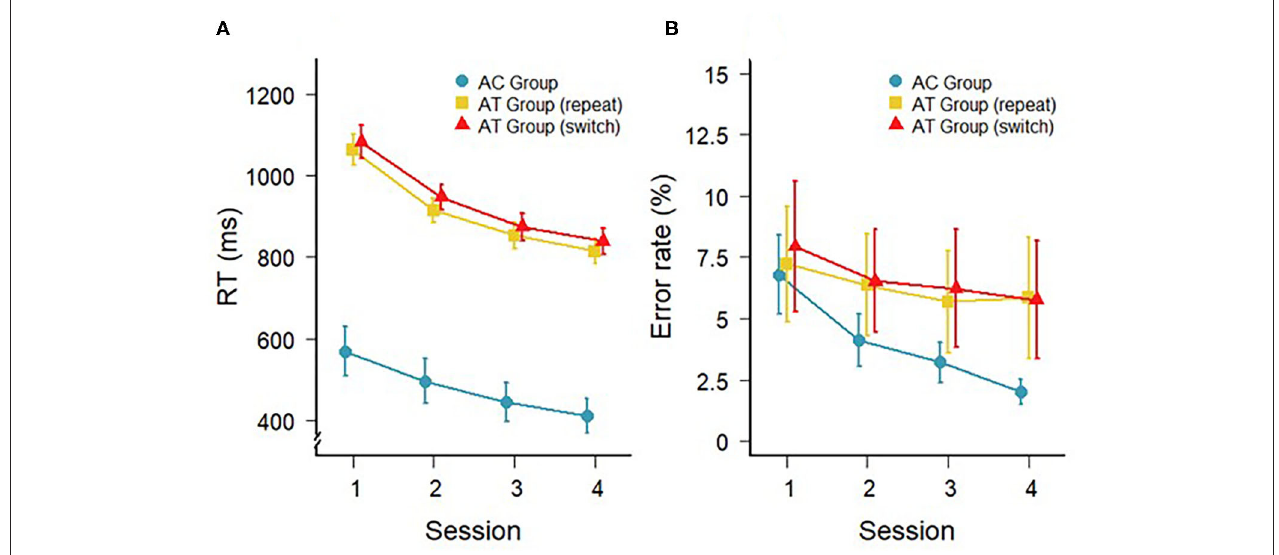
FIGURE 1 | (A) Mean RTs (in ms) and (B) mean error rates on repeat and switch trials during task-switching training of the AT group and during the single task training of the AC group (repeat trials only). Error bars depict standard errors of the mean.